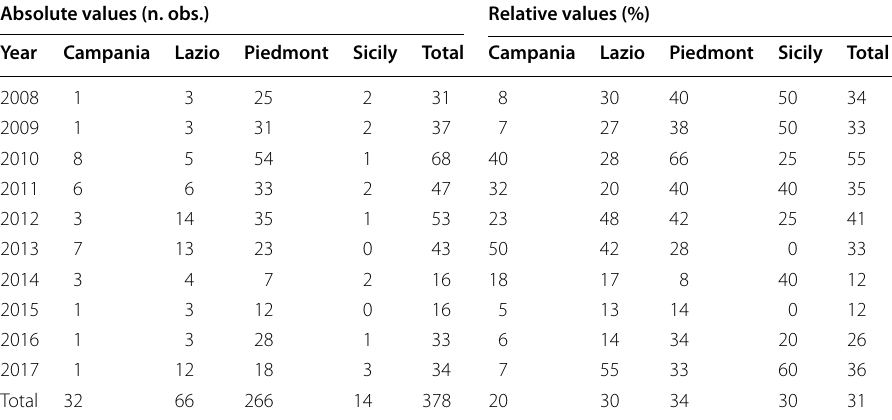
Table 6 Number of cases of indemnification by region and year Absolute values (n.